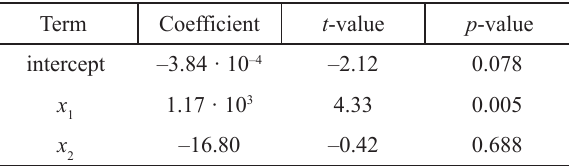
Table 4 – Results of regression analysis for the penetration rate in response to the inverse of the solution and polarization resistances